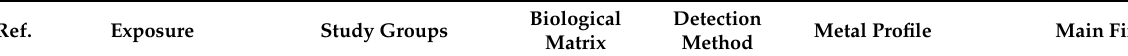
Table 6. Articles studying the relationship between heavy metals and reproductive outcomes in couples from assisted- reproduction